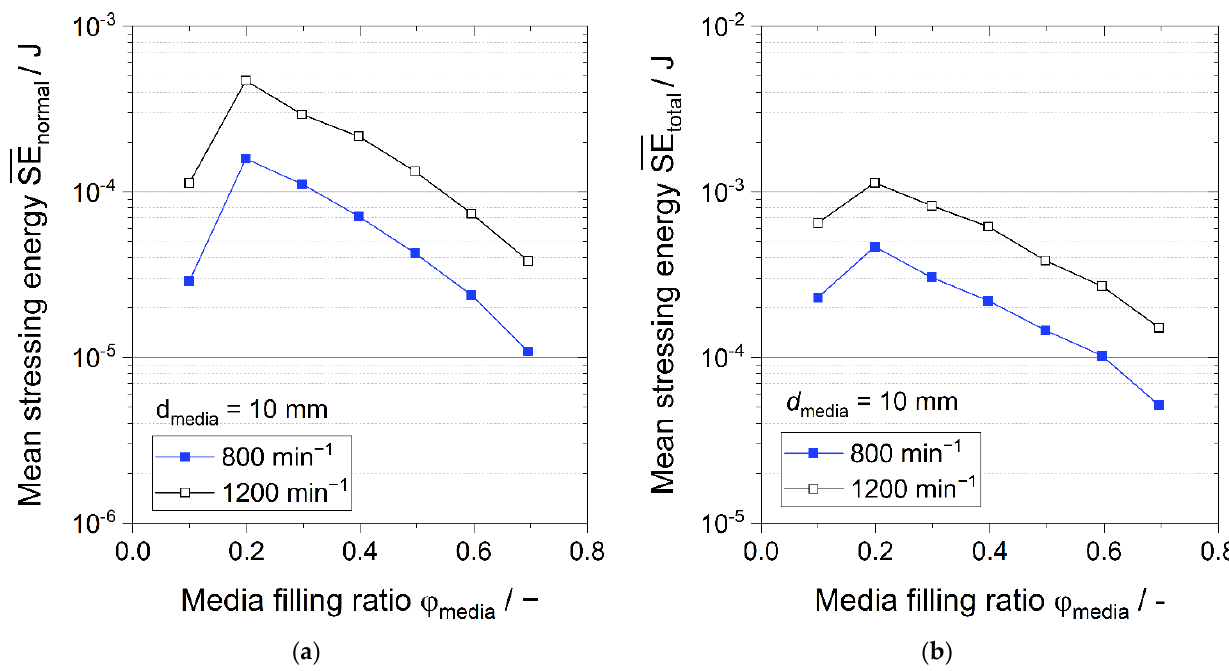
Figure 8. ( a ) Normal mean stressing energy and ( b ) total mean stressing energy in dependence on media filling ratio; d media = 10 mm.